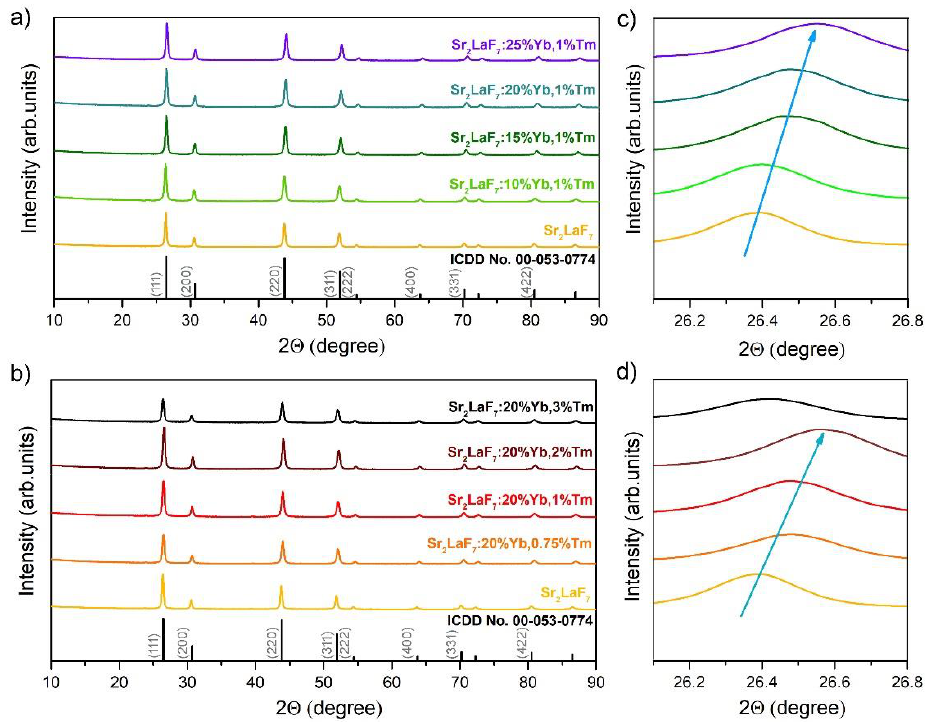
Figure 2. XRD patterns of ( a ) SLF:xYb 3+ ,1 mol%Tm 3+ and ( b ) SLF:20 mol%Yb 3+ ,yTm 3+ nanophos- phors. ( c ) The evolution of the (111) diffraction peak magnified from ( a ). ( d ) The evolution of the (111) diffraction peak magnified from ( b ). Arrows indicate changes of the peak position maximum. Table 1. Results of the structural analysis by using WPF refinement of SLF:xYb 3+ ,1 mol%Tm 3+ nano- phosphors.